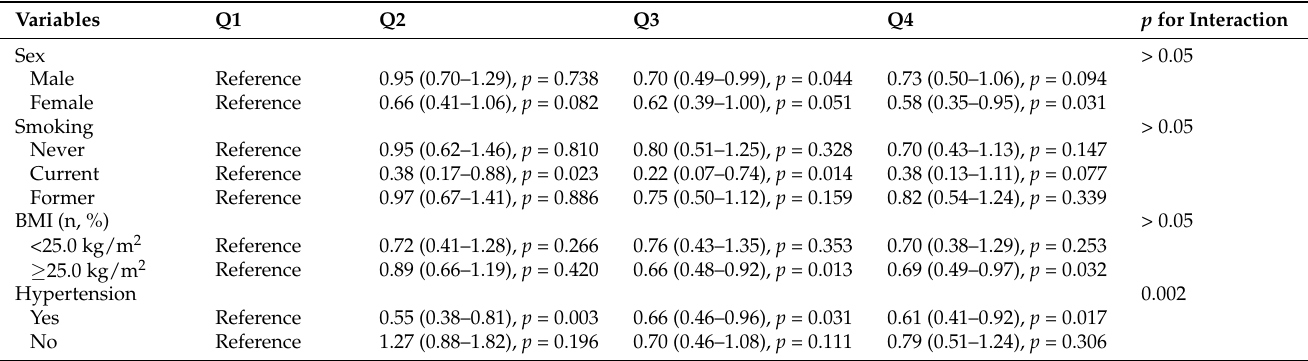
Table 4. Subgroup analyses between dietary anthocyanidin intakes and renal cancer